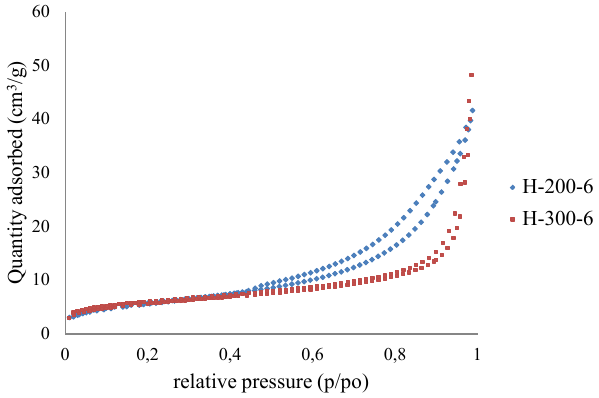
Figure 4. Nitrogen adsorption and desorption isotherms for H-200- Figure 4 . Nitrogen adsorption and desorption isotherms for H-200-6 and H-300-6 6 and